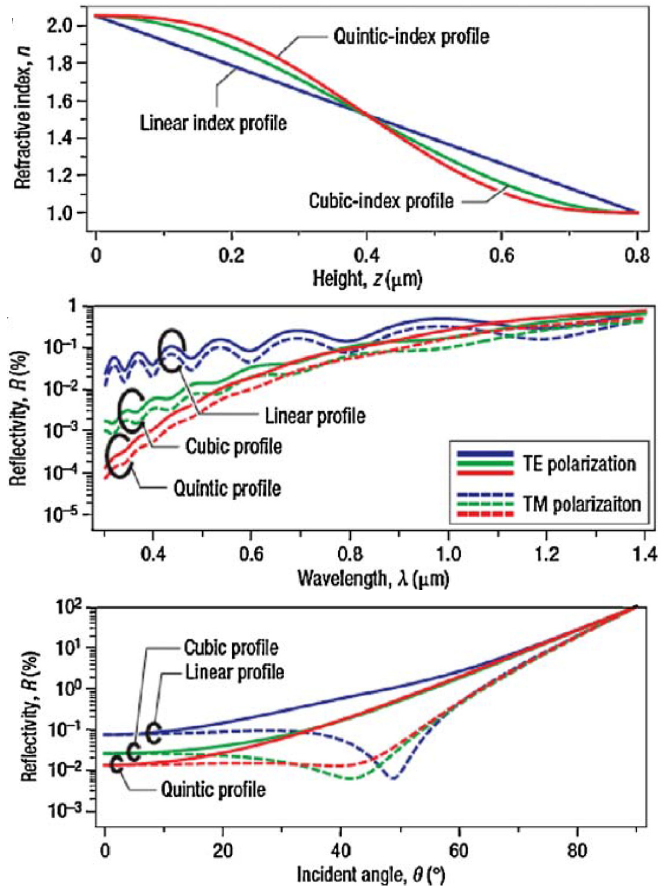
Figure 9. Reflectivity of several GRIN structures over a range of heights, wavelengths, and angles of incidence. Reprinted with permission from reference [23], Copyright 2007 Nature Publishing